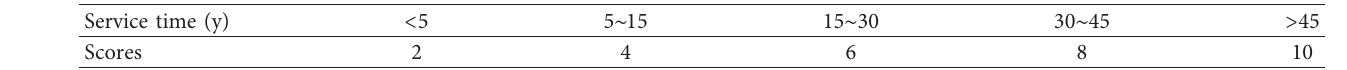
Table 17: The scores of service time.